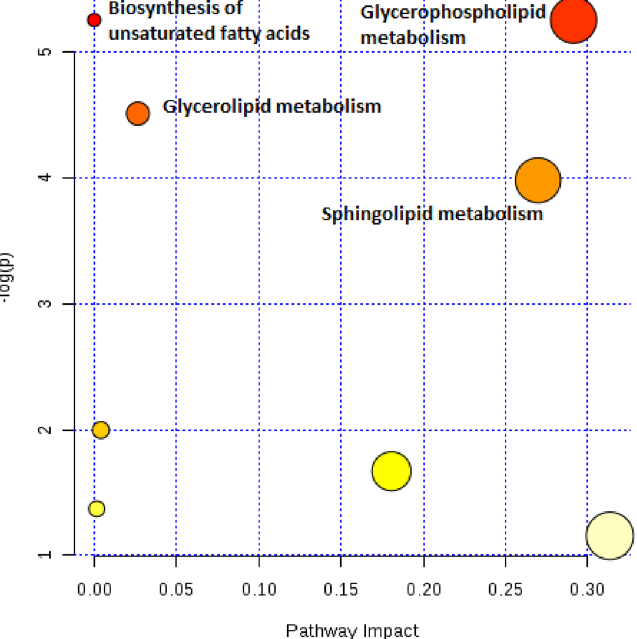
Figure 2. Diagram of metabolic pathways for lipid species with statistically significant abundance variation common for benign tumor and myometrium during recurrence of